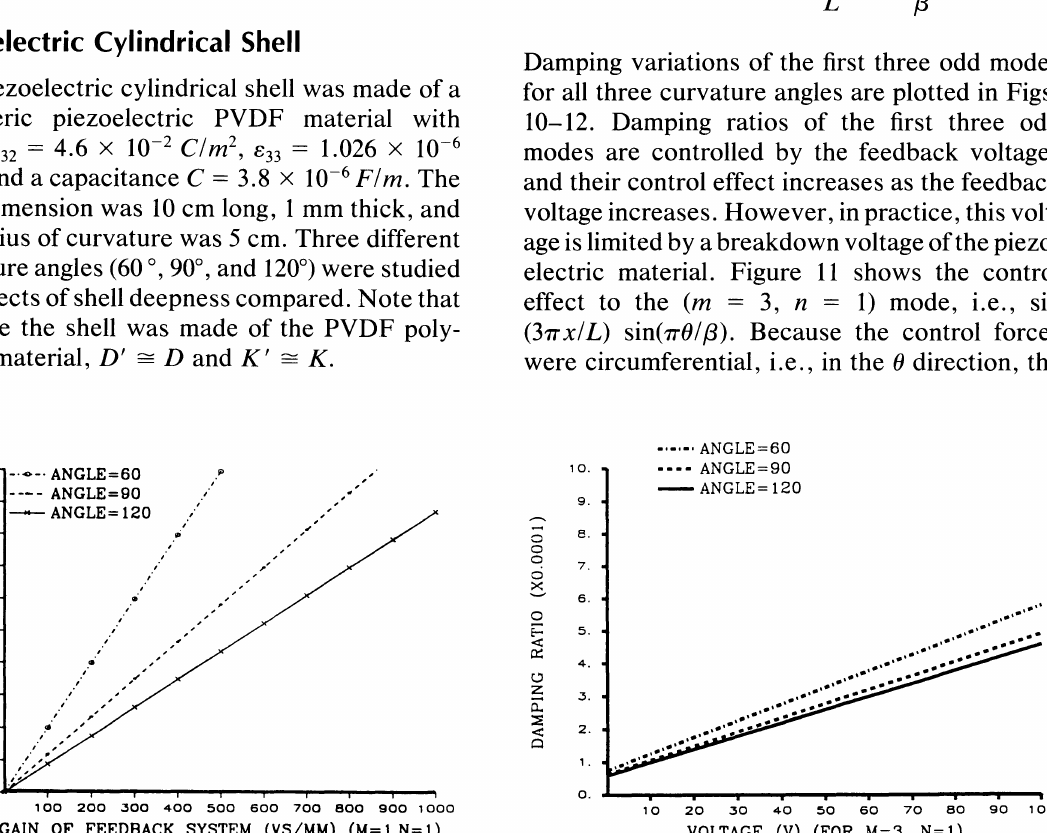
FIGURE 10 Damping control of the piezoelectric shell, (1, 1) mode.